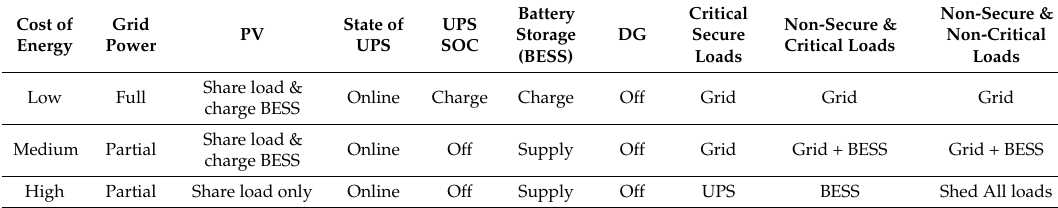
Table 3. Power sharing between DES, Grid and Loads during On Grid mode of operation.